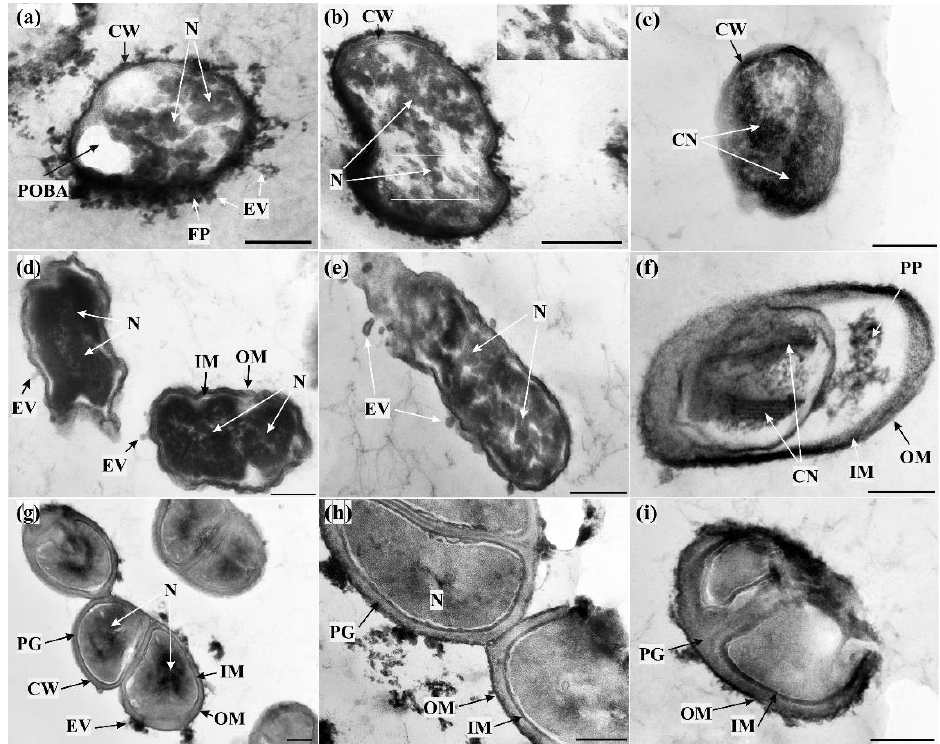
Figure 8. Cell morphology in E. coli ( a – c ), P. aeruginosa ( d – f ) and K. rhizophila ( g – i ) on the 2nd ( a , b , d , e , g , h ) and 28th ( c , f , i ) days of incubation in the mono-species biofilms. N, nucleotide; CN, crystallized nucleotide; CW, cell wall; OM, outer membrane; IM, inner membrane; PP, periplasm; PG, peptidoglycan; POBA, poly-oxybutyric acid; EV, extracellular vesicles; FP, fibrillar polysaccharide. Bar, 0.2 µm.